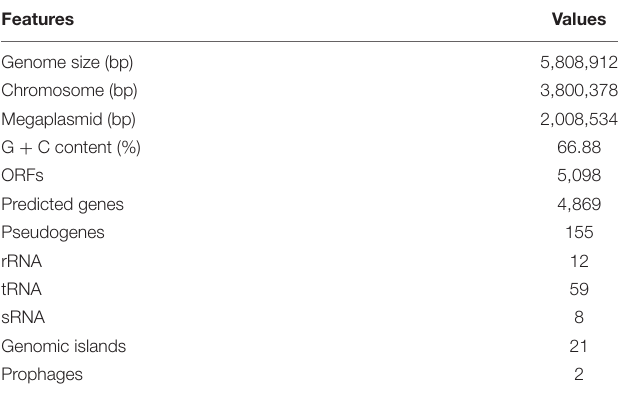
TABLE 1 | General features of the R. solanacearum PeaFJ1